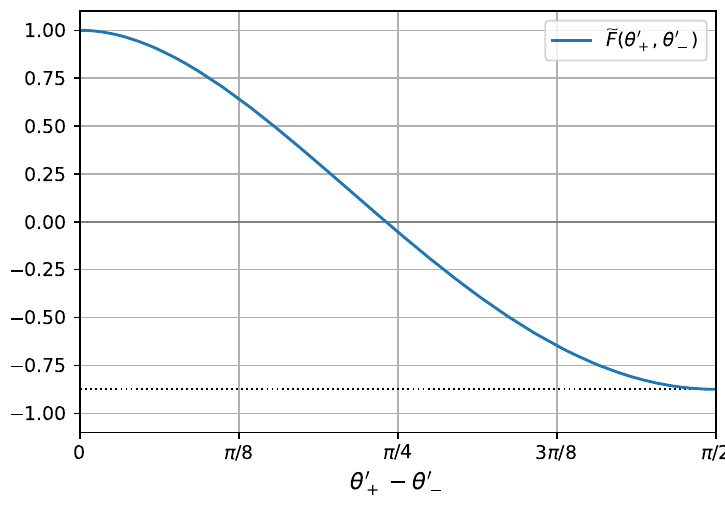
(cid:0) (cid:1) θ 0 , θ 0 in terms of the duality angles θ 0 + − . The Casimir force vanishes at θ 0 8